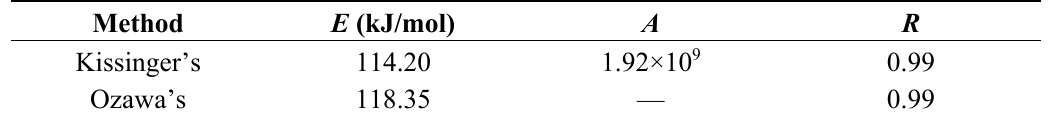
Figure 16. Relationship between lg β and 1/ T p . Table 6. Thermal reaction kinetic parameters of Sample 5 paraffin-based fuel in O 2